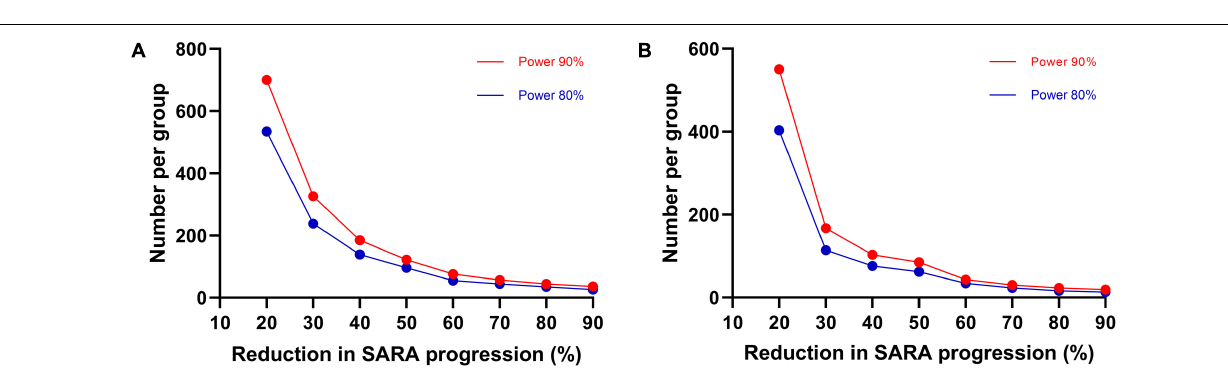
onset ( − 0.010 [SE 0.005] per year, p = 0.036), longer